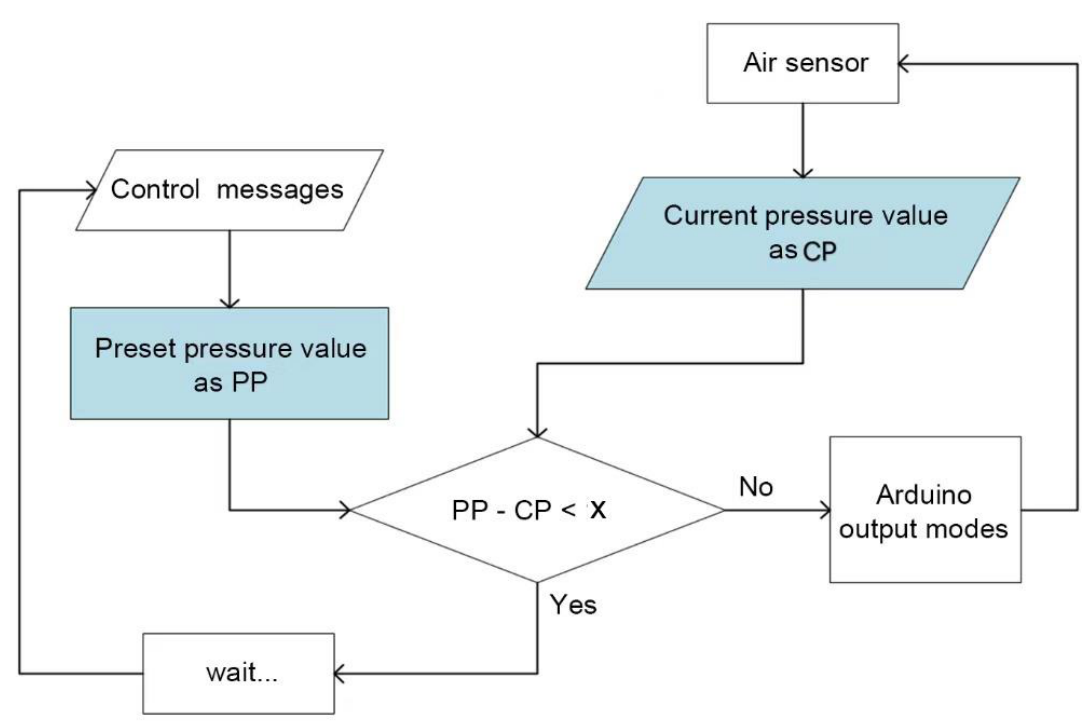
Figure 6. The control board. ( a ) The schematic diagram. ( b ) The prototype. The microcontroller Arduino could shift between output modes of either supply air, release air, extract vacuum, or stay loop close. According to Figure 7, the control messages were compared with real-time states to decide the power mode. The control messages were transformed into the corresponding preset pressure that was able to assist in specific hand motion. The current pressure was monitored upon an air sensor. If the value of PP were close to that of CP, the system would delay and wait for the next control message; or the control system would keep adjusting until meeting the condition. When PP-CP is less than an acceptable value of error x. When x is infinitely close to 0, CP is much closer to PP. However, in this experiment, taking into account the performance of air pump, we set x as 1 KPa for RE, and we set x as 5 KPa for SF and RS.